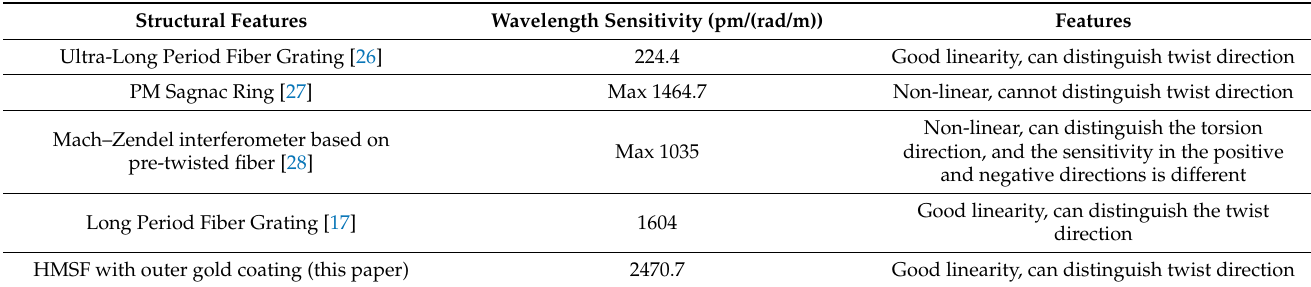
Table 1. Comparison of distortion sensing results with other sensing